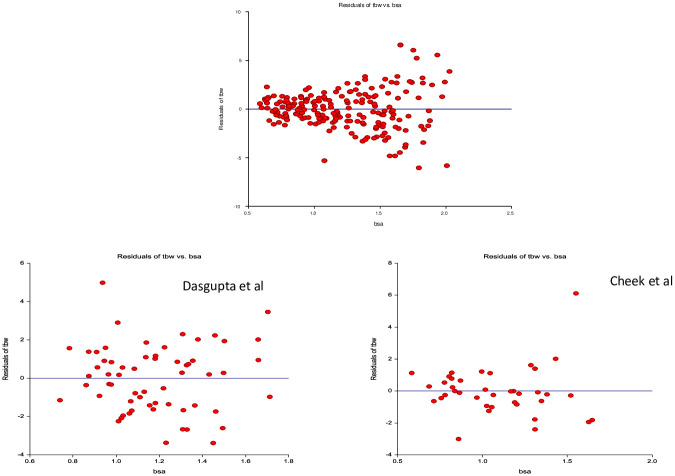
Comparison of regression residuals between bioimpedance and dilution methods.BIA: Bioimpedance analysis; TBW: Total body water; BSA: Body surface area; Studies by dilution method (Cheek14, Dasgupta15).